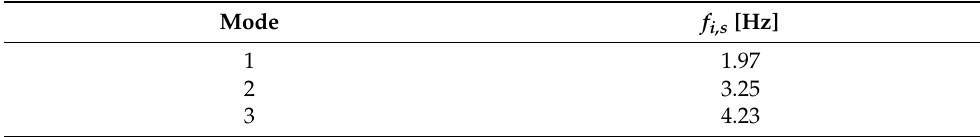
Table 10. Experimental eigenfrequencies of the steel frame.